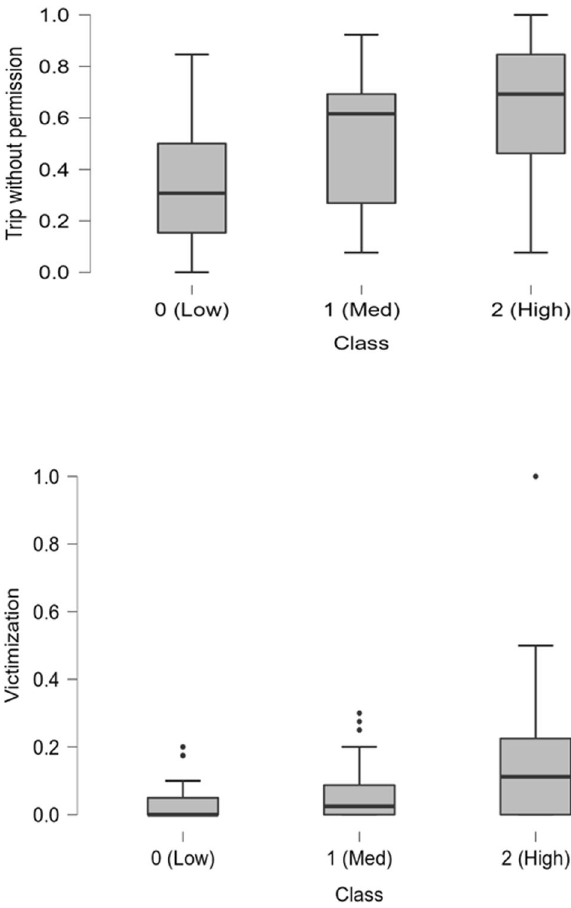
Fig. 5 The box plots of two major attributes viz. attitude towards delinquency and peer attachment. X -axis indicates the 3 classes and Y-axis indicates the given feature.